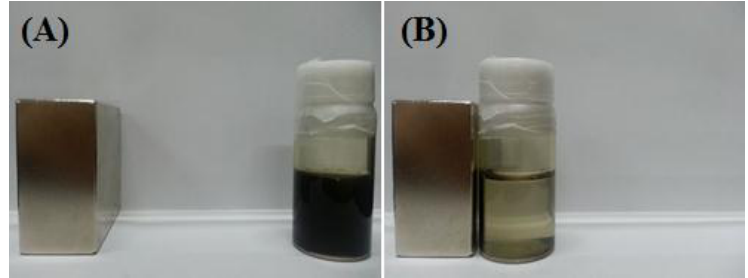
Figure 5. The separation of radioactive cesium ( 137 Cs) using a magnet from Prussian blue-coated PDDA@Iron